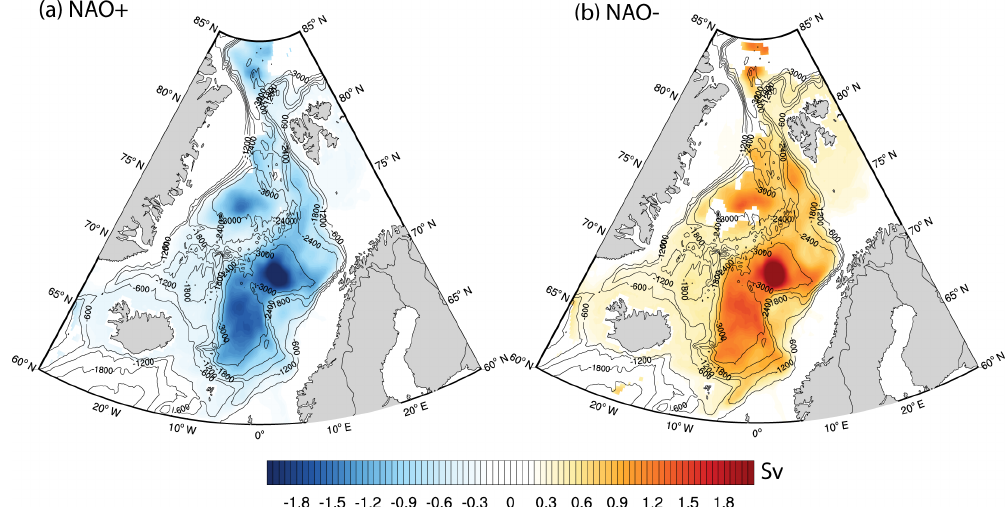
Figure 11. Composite map of anomalous BSFD, during (a) NAO + and (b) NAO − . Black isobaths are drawn for every 600m. Anomalies are computed using monthly climatology fields for the period 1991–2015. Only significant anomalies (10% significance level) are shown.